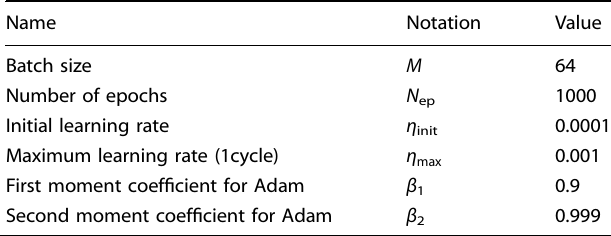
Table 2. Training